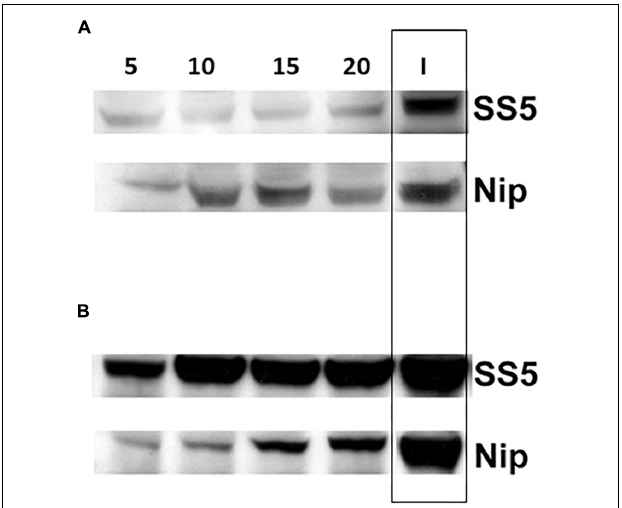
FIGURE 7 | Western blot analysis of (A) SSIIa and (B) GBSSI protein expression in the total protein extract from developing grains of hp-SSIIa-op (SS5) compared with Nipponbare (Nip) using 5–20 DPA grains. 15 DPA IR64 (I) was used as a reference positive control band (boxed). Days of each sample is labeled above the lanes (5, 10, 15, and